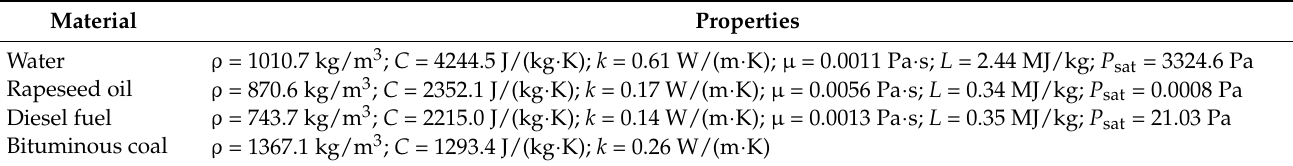
Table 1. Thermophysical and transport properties of CWS and CWSP components at T = 300 K